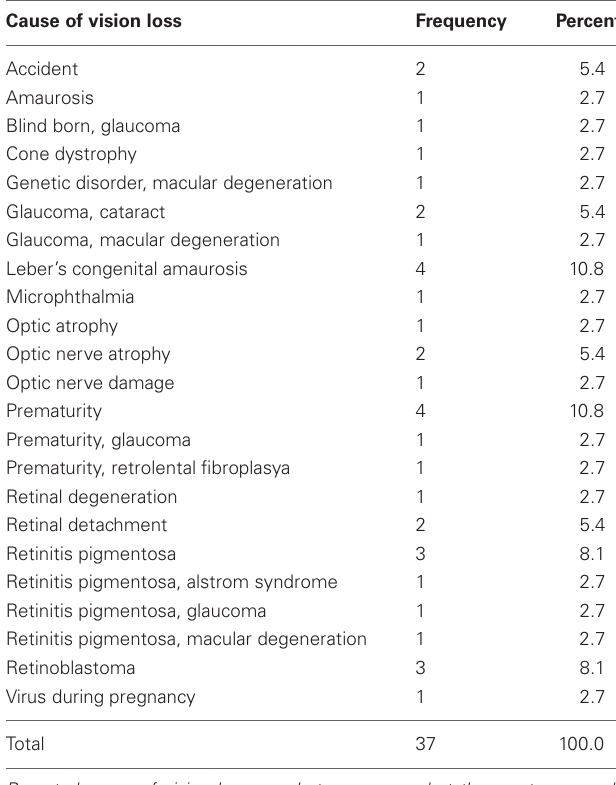
Table 1 | Summary of participants’ responses to survey question 6 “When did your vision loss start.”